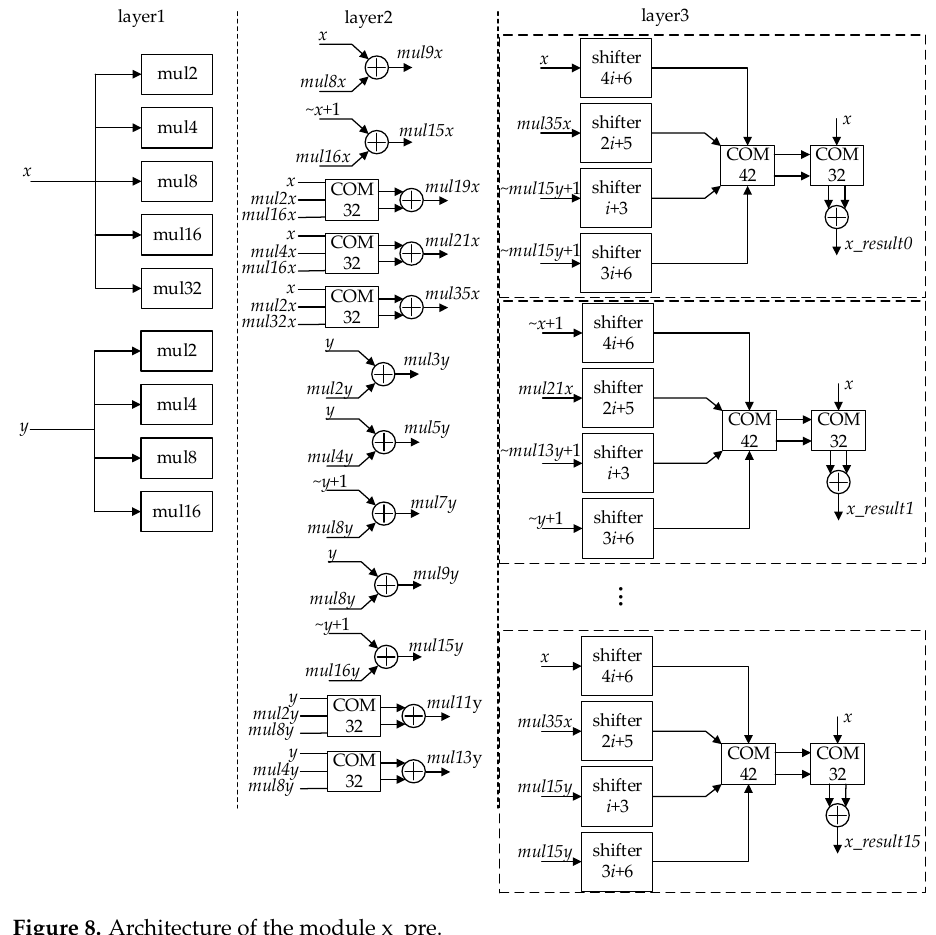
Figure 8. Architecture of the module x_pre. Architecture of the module y_pre is quite similar to module x_pre. Iterative Z data path calculation is also optimized and its architecture is shown in Figure 9.